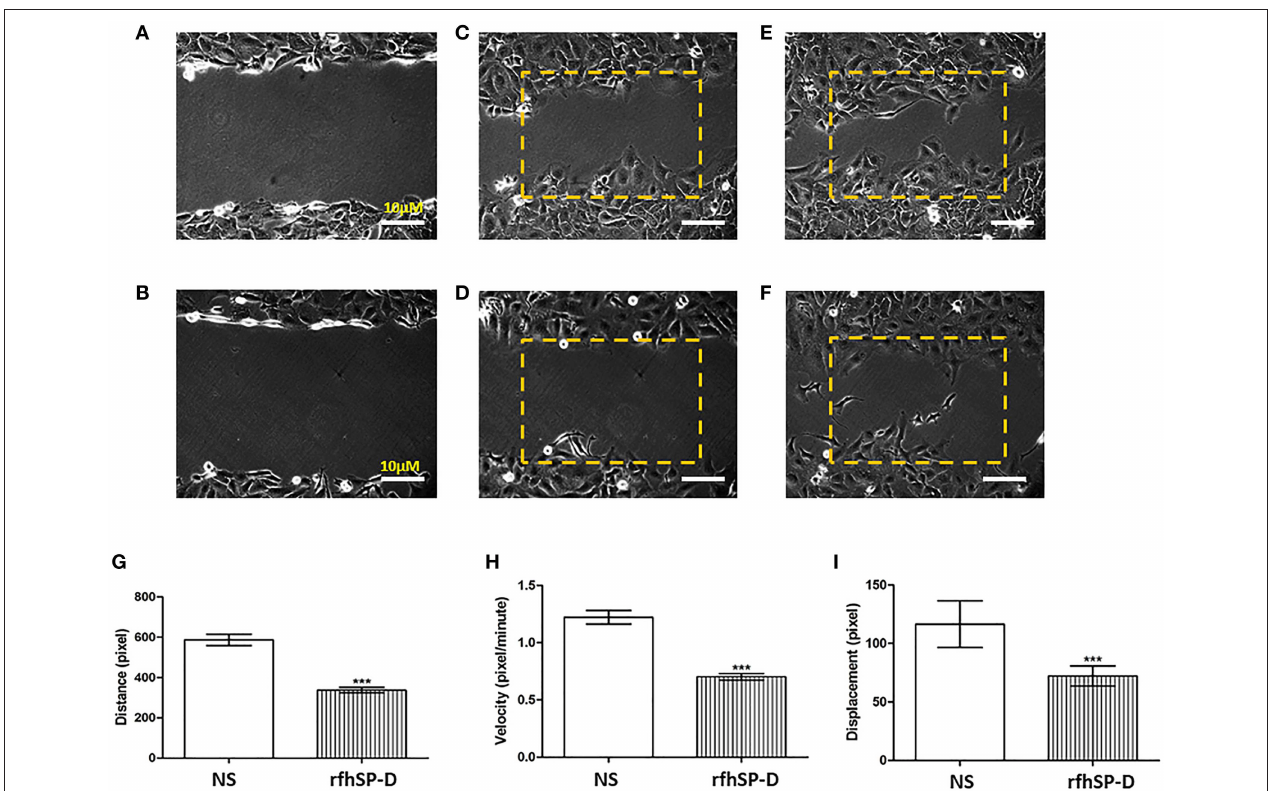
FIGURE 6 | Wound healing assay. The artificial wound created on the cell surface in untreated cells (A) and rh-SPD treated cells (B) at 0h. Untreated cells (C) or treated cells with rfhSP-D (D) did not appear to close the gap after 12h. At 24h untreated cells managed to close the gap (E) whereas rfhSP-D treated cells did so after 30h (F) . rfhSP-D treated SKOV3 cells have their distance (G) , velocity (H) , and displacement (I) reduced, compared to control SKOV3 cells. 25 cells were counted for each experiment. Comparisons ± SEM between untreated (NS) and treated SKOV3 cells with rfhSP-D at 10 µ g/ml (*** p <